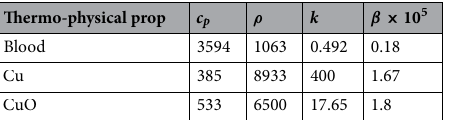
Table 1. Thermo physical characteristics of blood, CuO and Cu 15,27